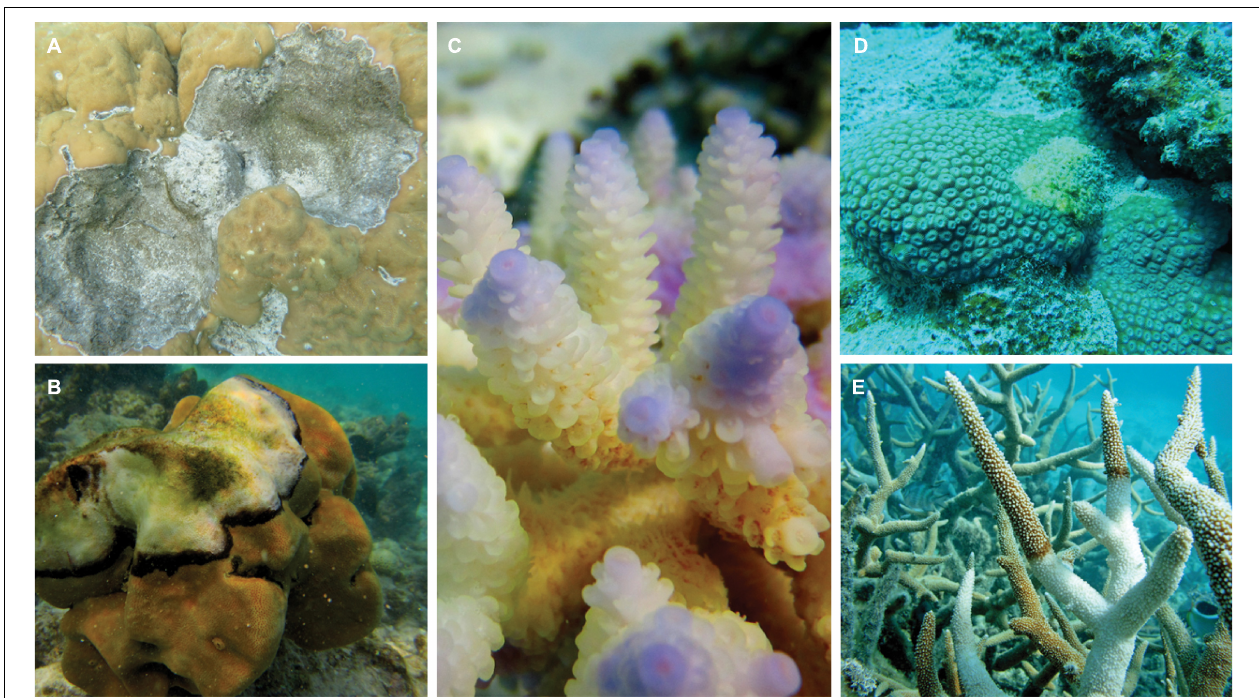
FIGURE 4 | Examples of coral diseases: (A) gray-patch disease, (B) black band disease, (C) bleaching, (D) white syndrome, (E) brown band disease. Photographs credits: A/Prof. Michael Sweet (A–D) and A/Prof. David Bourne (E)